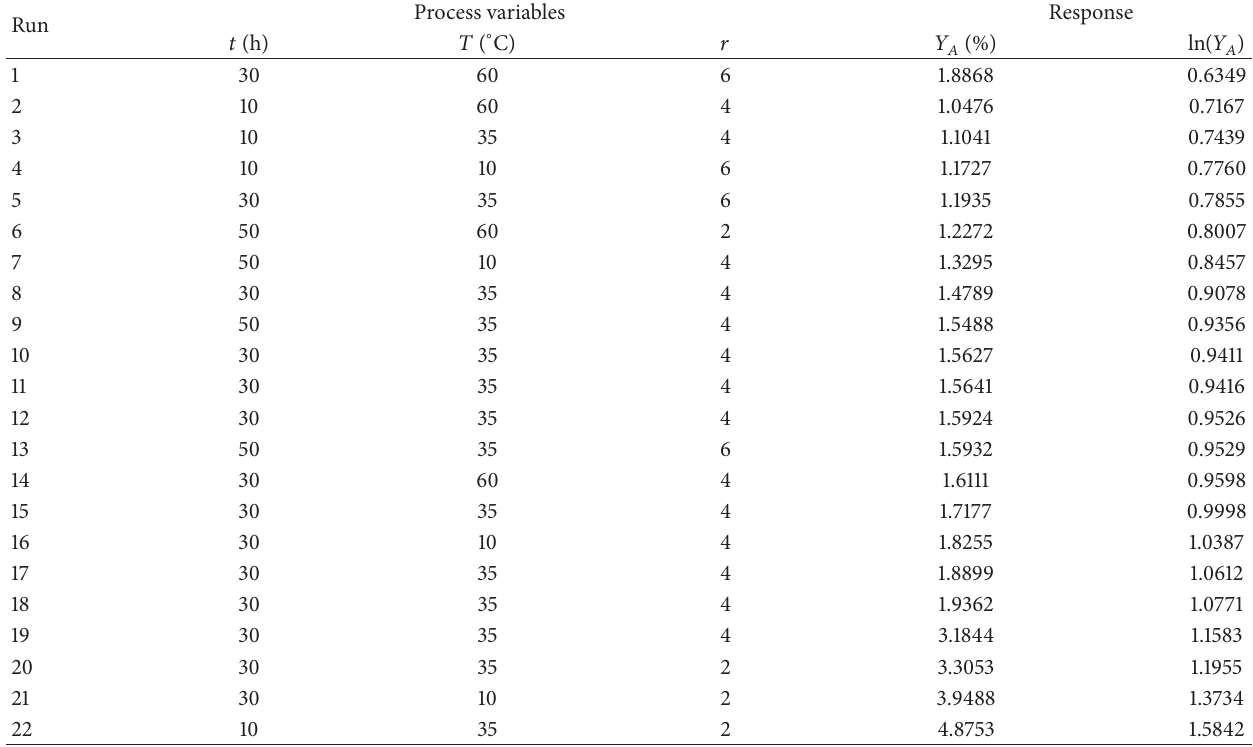
Table 1: Sorted CCD and response data for liquid-liquid extraction of spent lubricant with alcohol (1-butanol).